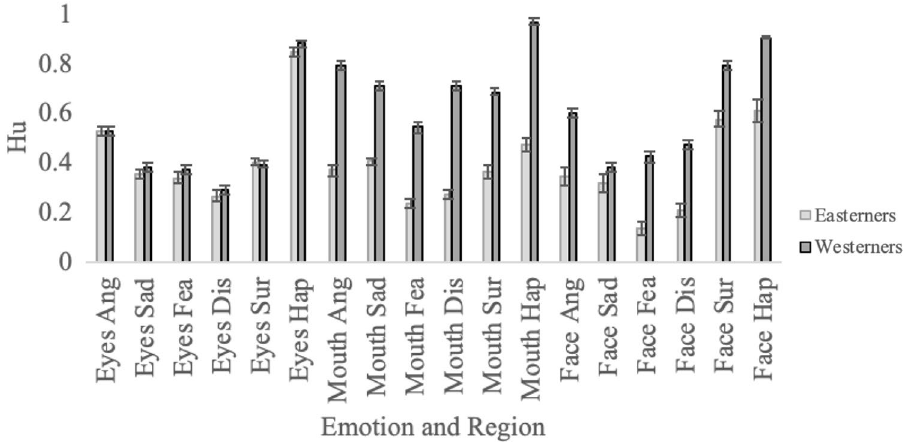
Figure 3. Easterners’ and Westerners’ emotion recognition when shown the eyes, mouth or full face. Note. Bars represent standard errors. There was no difference in the emotion recognition of Easterners and Westerners on the Eyes Only stimuli. In contrast, Easterners were worse on all six emotions of the Mouth Only stimuli and the same was true for the Full Face